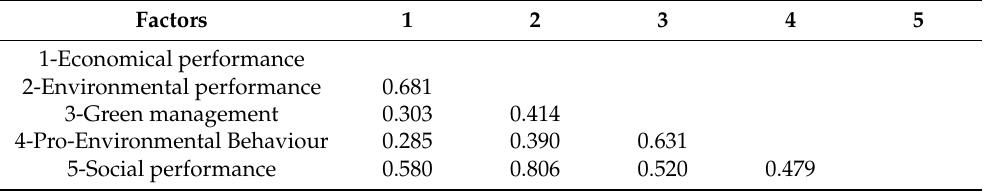
Table 3. HTMT Matrix.